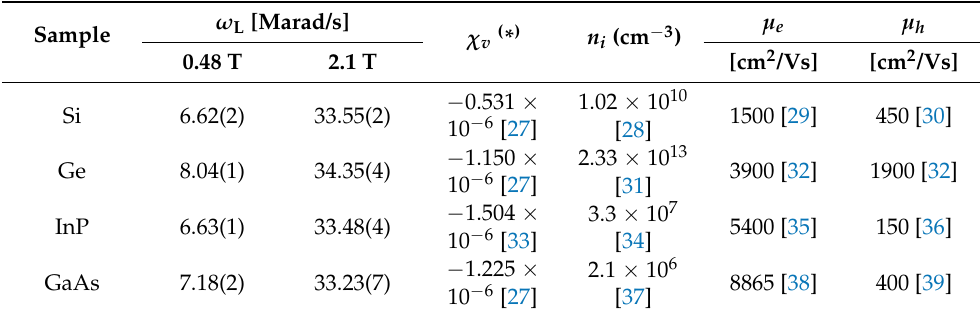
Table 2. Experimental Larmor frequencies ω L , volume magnetic susceptibility χ v , intrinsic carrier concentration n i , electron µ e and hole µ h mobilities at 300 K.